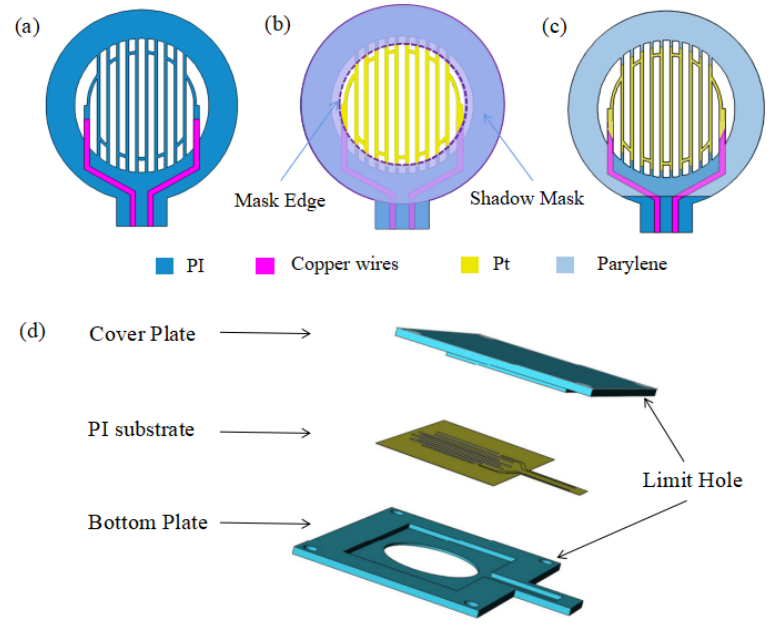
Figure 2. Fabrication processes of the perforated respiratory sensor. ( a ) Print two copper leads on PI substrate and laser cut the target pattern. ( b ) Pt deposition on PI substrate with shadow mask. ( c ) Parylene-C deposition on the surface. ( d ) The shadow mask is designed as a bottom plate with a graphic groove and a cover plate with limit holes.